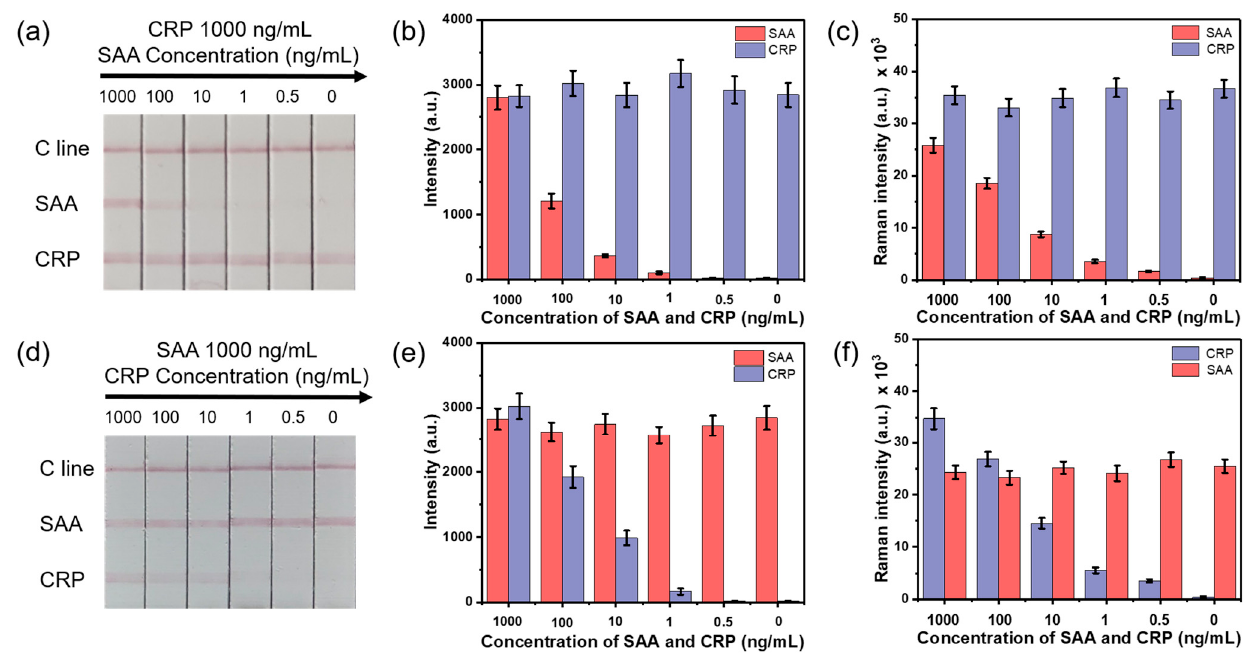
Figure 3. Sensitivity and specificity of the Au MBA @mSiO 2 -based LFA strips. ( a , d ) Photographs of the test LFA strips. ( b , e ) The corresponding brightness values of two test lines and ( c , f ) the corresponding Raman intensities at 1079 cm − 1 of two test lines. The error bars indicate the standard deviations calculated from five separate experiments.